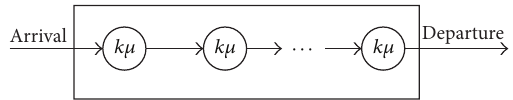
Figure 1: Schematic representation of Erlangian service facility with 𝑘